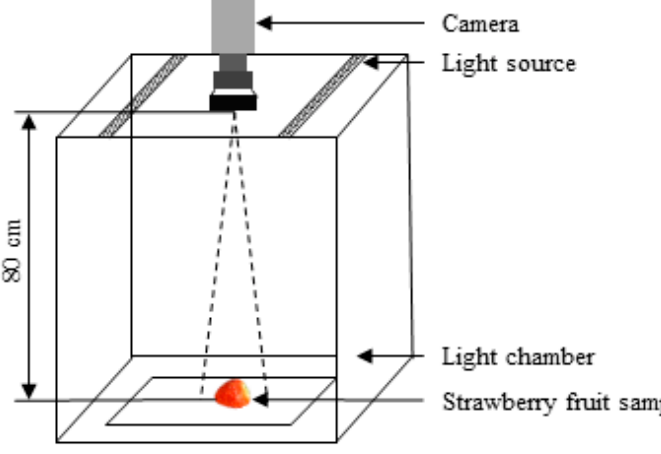
Figure 2. Schematic diagram of image acquisition system for strawberry